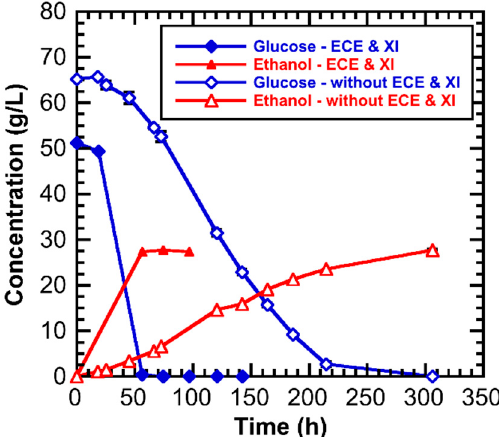
Figure 3. Effect of E. coli extract (ECE) and xylose isomerase on the glucose consumption rate and ethanol productivity for S. pastorianus cultured on sugarcane bagasse hydrolysate. Glucose ( , ); ethanol ( , ). With ECE and xylose isomerase ( , ); without ECE or xylose isomerase (XI) ( , ). The cultures were conducted in triplicate; however, ethanol was only evaluated for every third sample, except for the last sample, and for those cultures, all three samples were evaluated. Error bars represent the standard deviation.